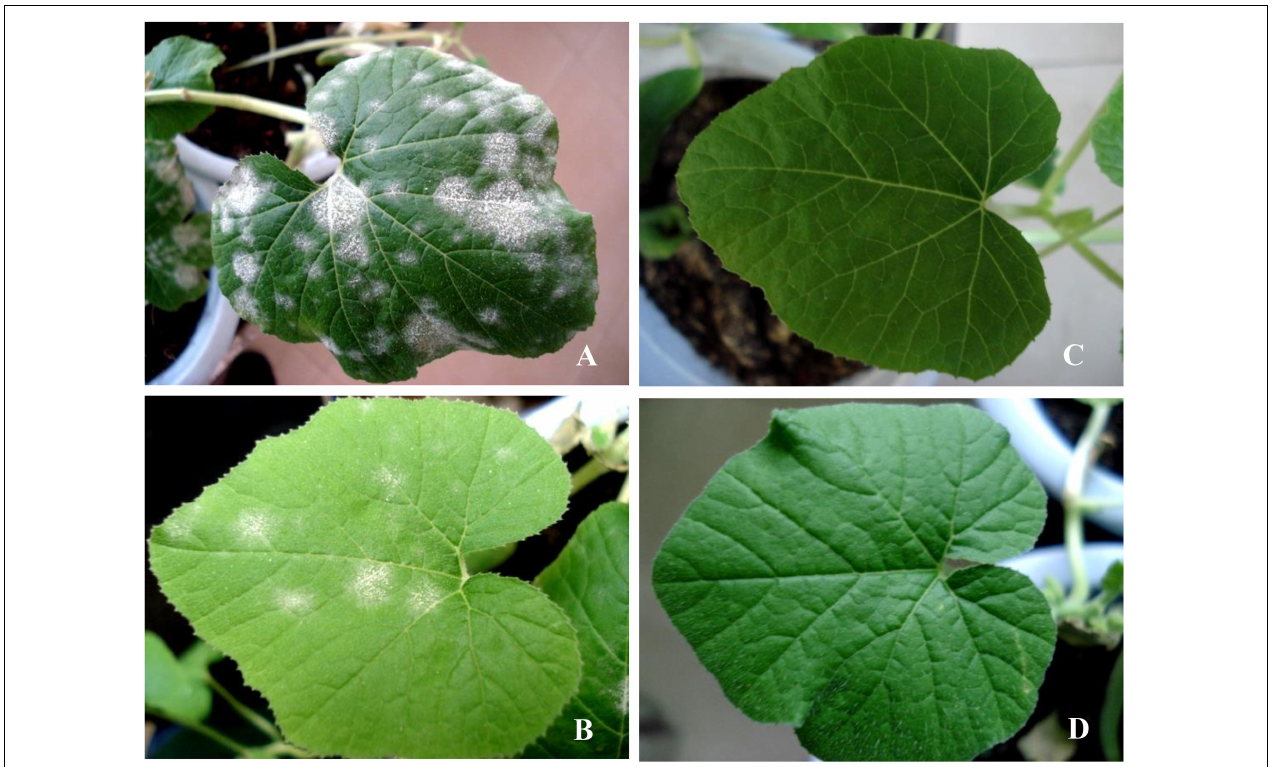
FIGURE 1 | The symptoms of different cultivars of Cucurbita pepo on the 13 th day after inoculation with the pathogen of Podosphaera xanthii . (A) The cultivar of Jin 12 F 1 after inoculation with P. xanthii ; (B) the cultivar of Sixing F 1 after inoculation with P. xanthii ; (C) the cultivar of Jin 12 F 1 after inoculation with sterile water but not P. xanthii ; and (D) the cultivar of Sixing F 1 after inoculation with sterile water but not P. xanthii